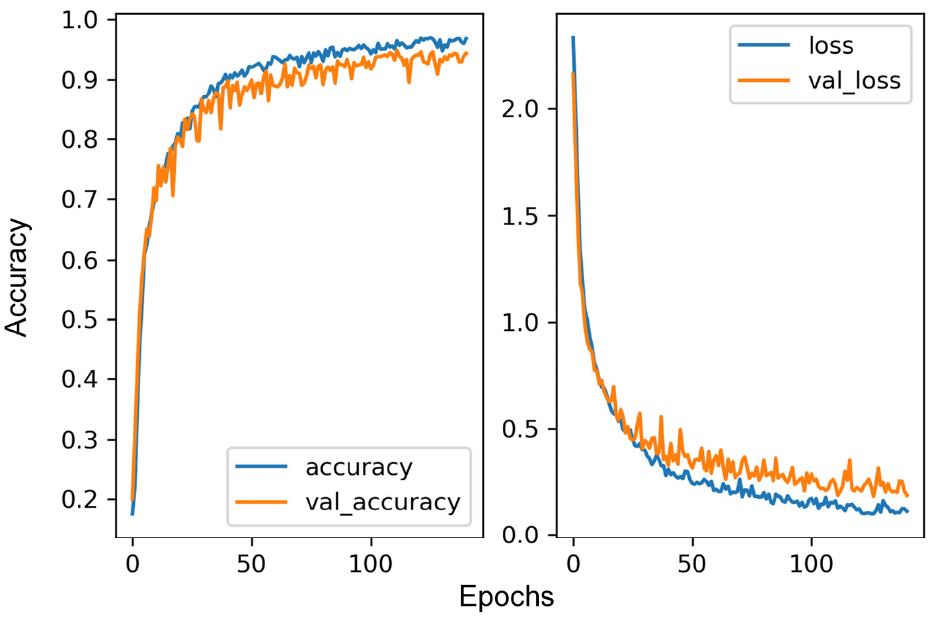
Figure 12. Accuracy of VGG16 models with data augmentation.